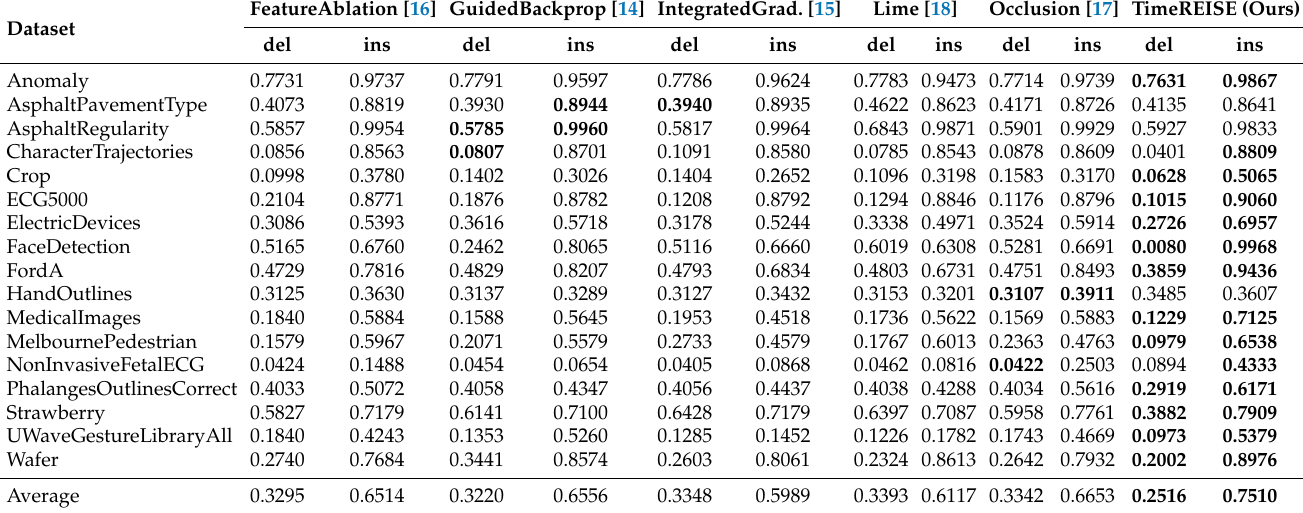
Table 3. Deletion & Insertion. Sequential deletion of the most important points from the original input signal. Respectively, sequential insertion of the most important points starts with a sample consisting of mean values. Lower AUC scores are better for deletion. Higher AUC scores are better for insertion. AUC was calculated using classification accuracy. TimeREISE outperforms any other methods concerning the deletion and achieves the best average for both deletion and insertion. Best results are highlighted in